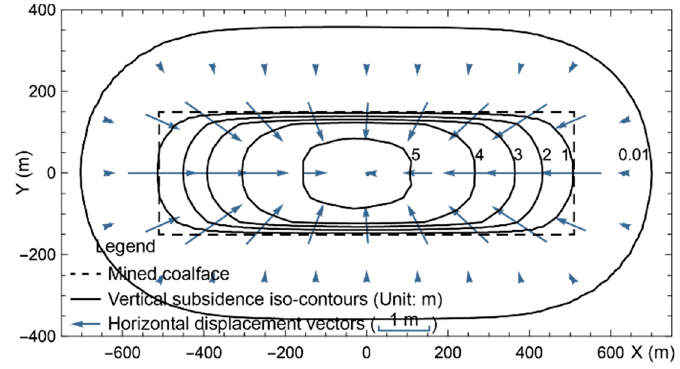
Figure 3. Vertical subsidence iso-contours and horizontal displacement vectors for Test 5. (2) Computation of Ground Deformations (Slope, Curvature and Horizontal Deformation) result of the simulations, but also by the ground deformations, including the slope, curvature and horizontal deformation. These deformation factors can be derived from the ground